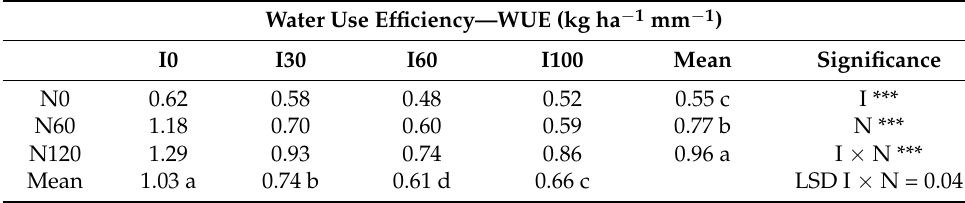
Table 6. Water use efficiency in relation to irrigation (I0, I30, I60, and I00 = 0, 30, 60, and 100% ETm, respectively) and N level (N0, N60, and N120 = 0, 60, and 120 kg ha − 1 N) (year 2022). The average values of all N levels (last column) and the average values of all irrigation levels (last row) followed by the same letter did not significantly differ at p ≤